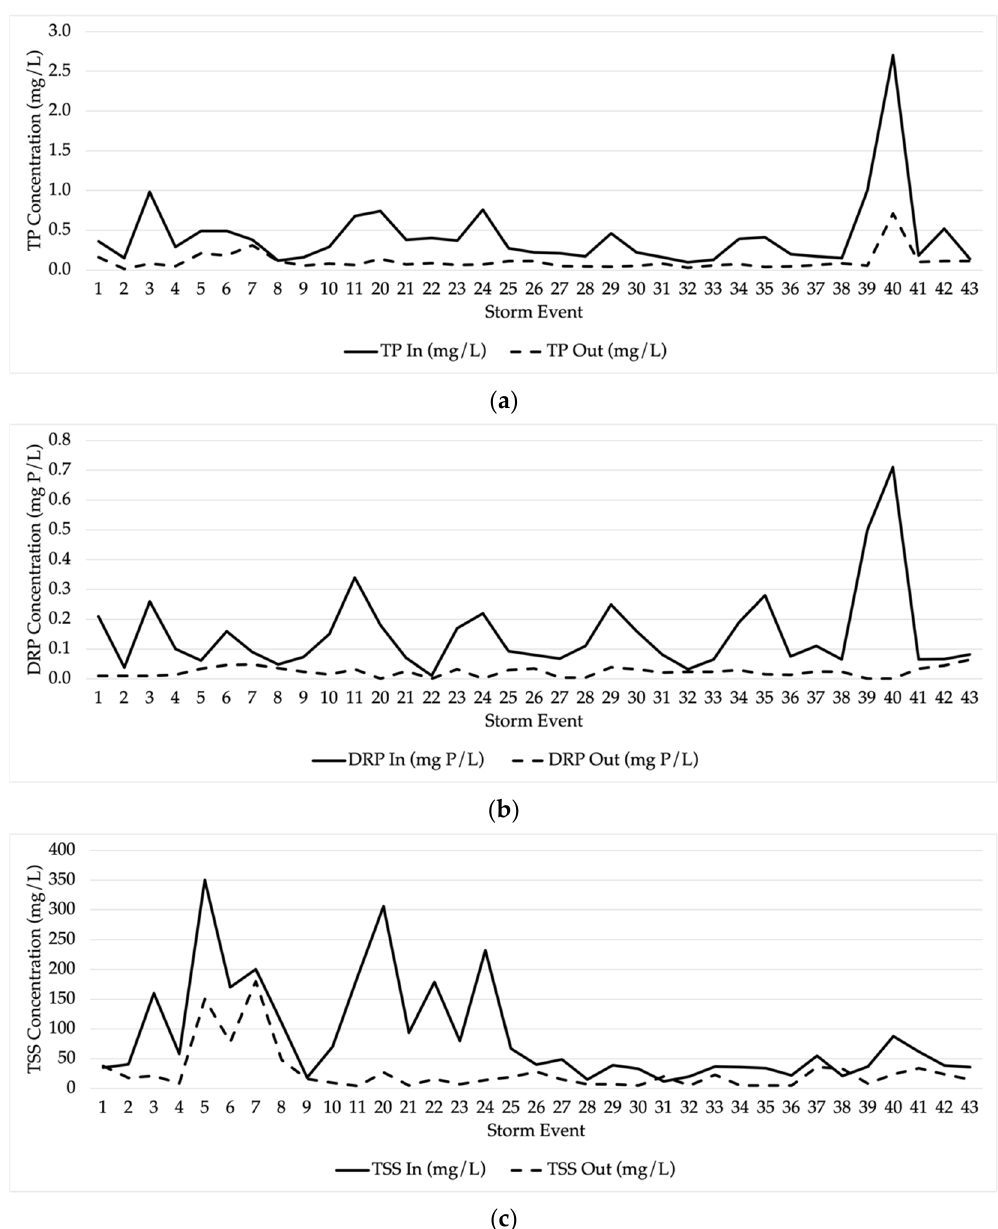
Figure 3. Flow-weighted average influent (solid line) and effluent (dotted line) concentrations of ( a ) total P, ( b ) total reactive P, and ( c ) TSS for 35 sampled storm events.